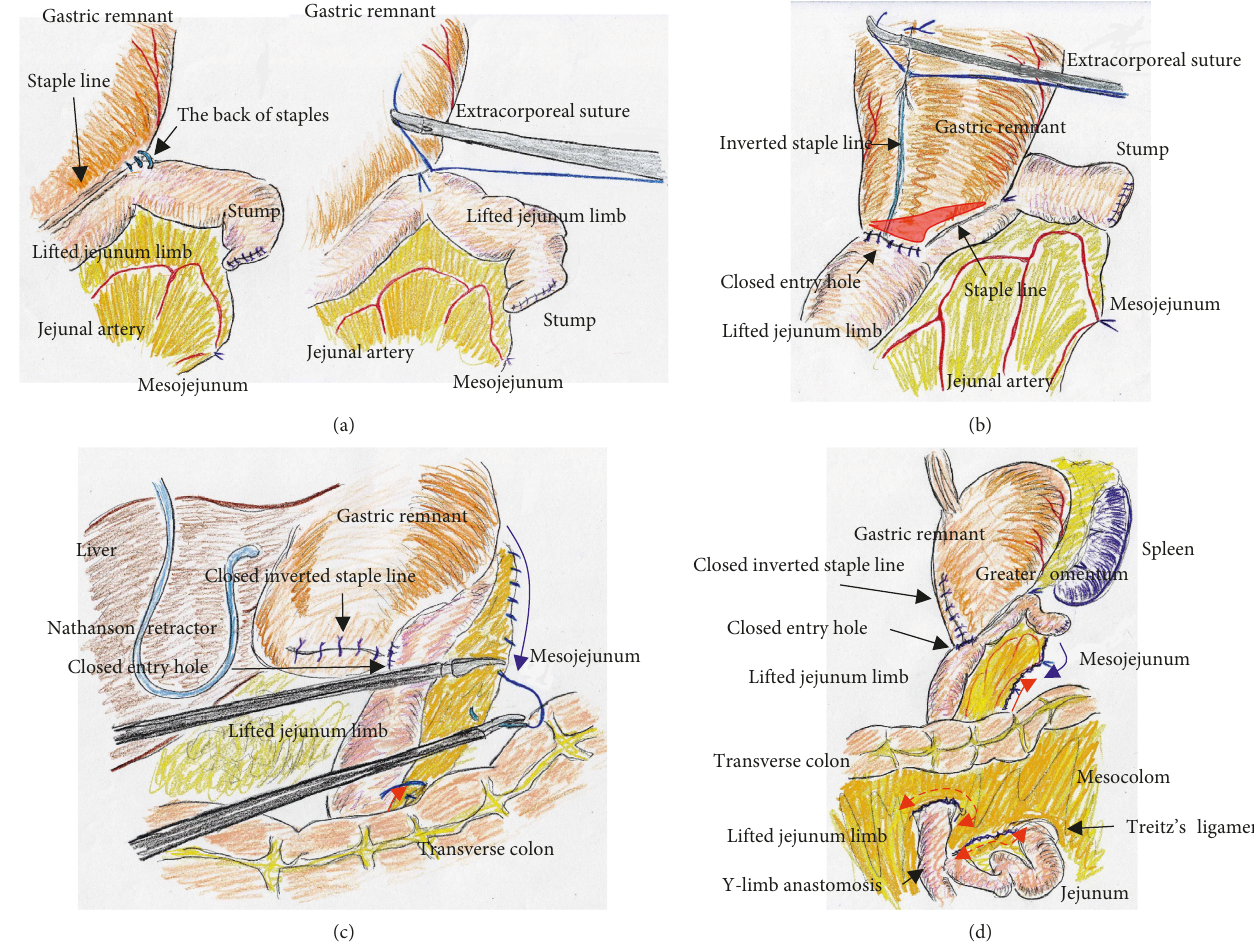
Figure 3: (a) A small number of seromuscular sutures were required at the tip of the endostapler. (b) We set the length of the staple line at 35–40mm for ideal side-to-side stapled anastomosis (red area). The endostapler entry site was carefully closed, and the inverted staple line in the gastric remnant was covered. (c) Through a small laparotomy, gaps in the mesojejunum could be closed even along the upper side of the mesocolon (red arrow). Therefore, intracorporeal sutures were required to close gaps in the mesojejunum only along the upper side of the mesocolon (blue arrow). (d) Through a small laparotomy, gaps in the mesojejunum from Treitz’s ligament (dotted red arrow) and the lower side of the mesocolon along the retrocolic route (dotted red arrow) could be closed. Intracorporeal sutures to close gaps in the mesojejunum were minimized (blue solid arrow) because of the closure along the upper side of the mesocolon through the small laparotomy (red solid